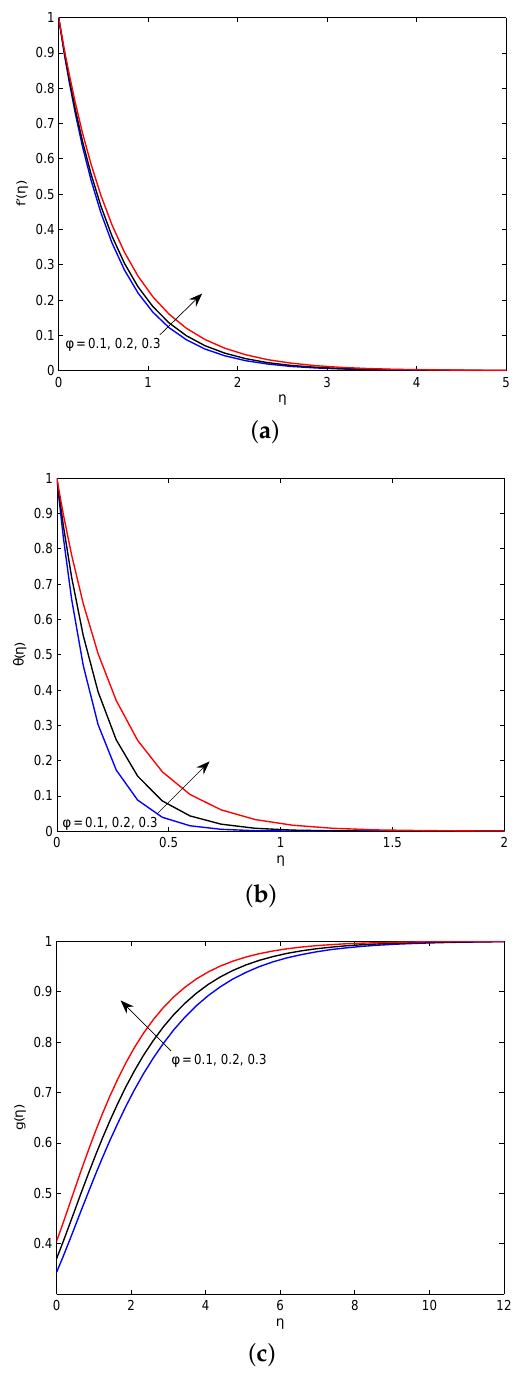
Figure 3. Variations in ( a ) f (cid:48) , ( b ) θ , and ( c ) g with respect to φ when M = 2, K = 0.5, K s = 0.5, β h = 2, Sc = 1 and Pr =